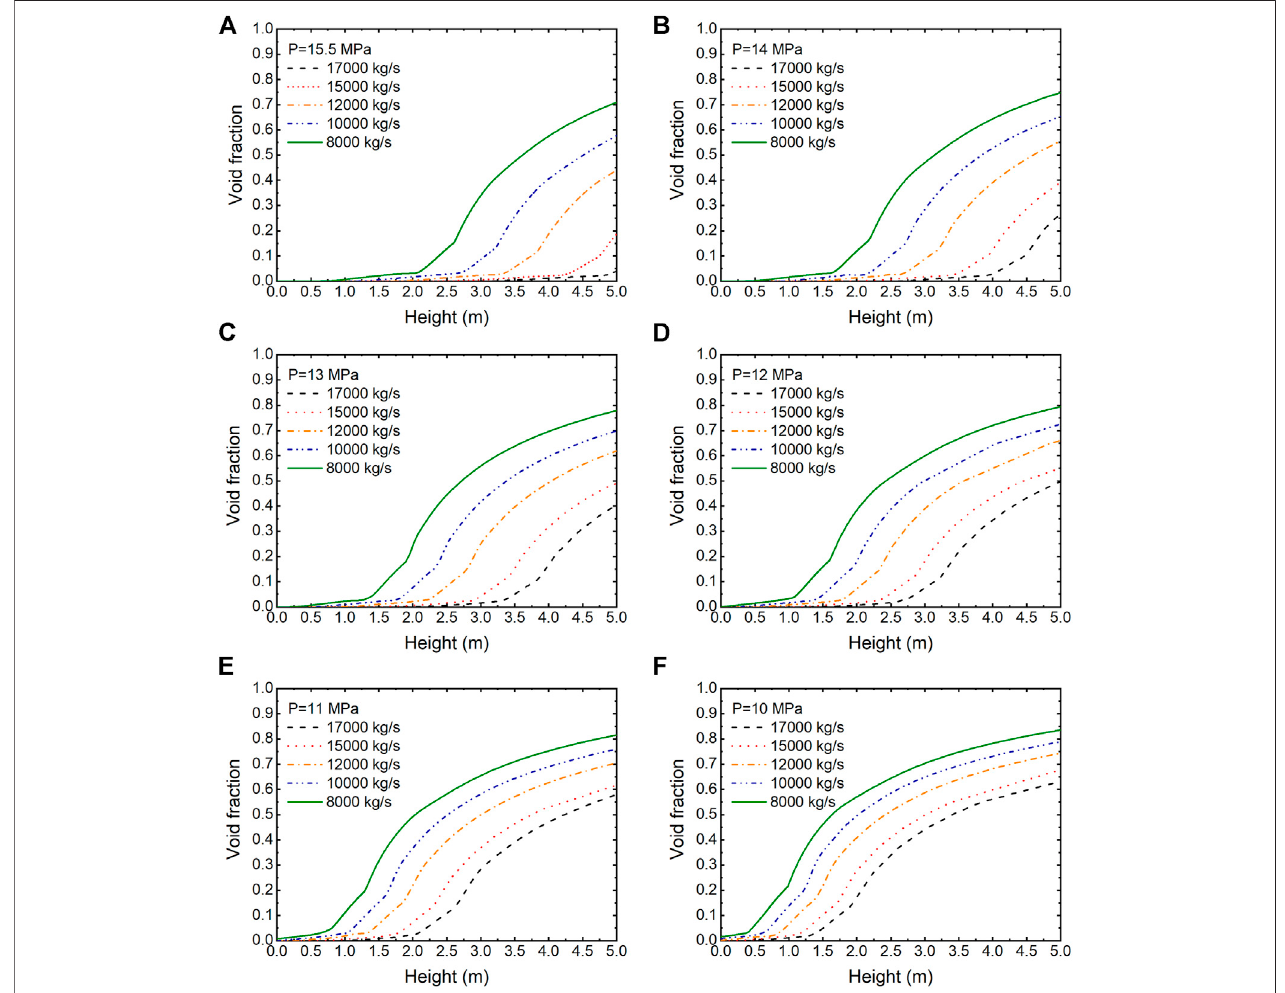
FIGURE 11 | Averaged void fraction as a function of height under different coolant pressures and mass fl uxes.